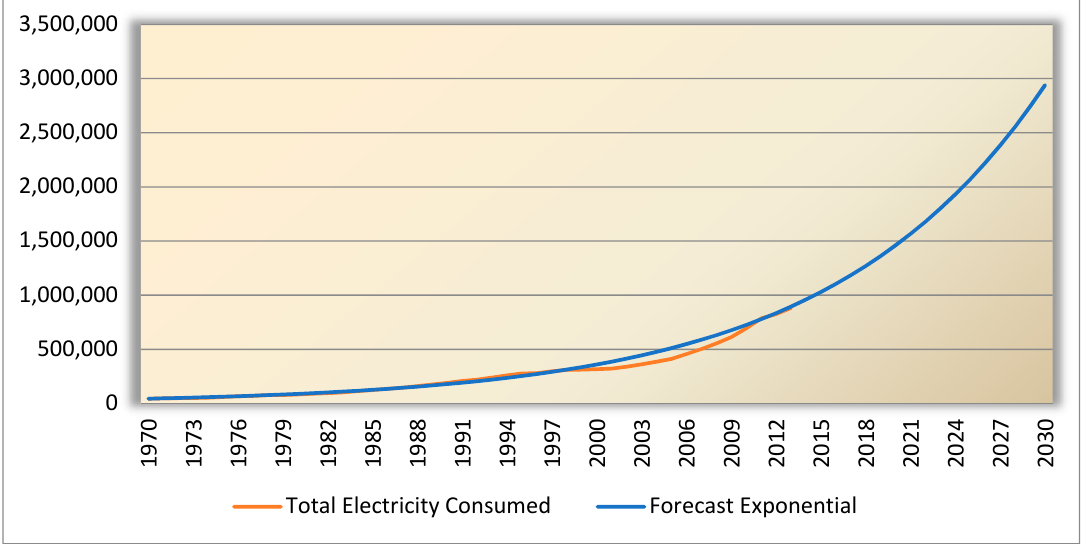
Figure 12. Chart for Exponential method (1971–2030).